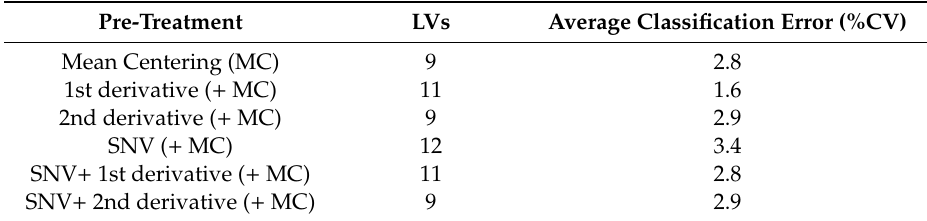
Table 2. Partial Least Squares-Discriminant Analysis (PLS-DA) modeling of the spectra collected on the nutshell–results of cross-validation (LVs: Latent variables).